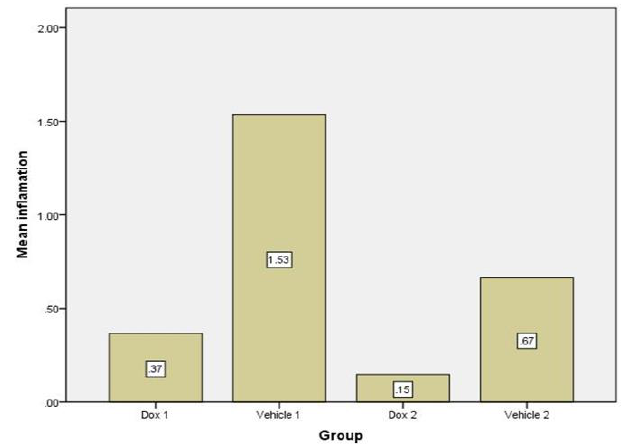
Chart 1. comparing the amount of inflammation, DOX 1: teeth treated with doxycycline gel only once, Vehicle 1: teeth treated with vehicle gel only once, DOX 2: teeth treated with doxycycline gel twice, Vehicle 2: teeth treated with vehicle gel